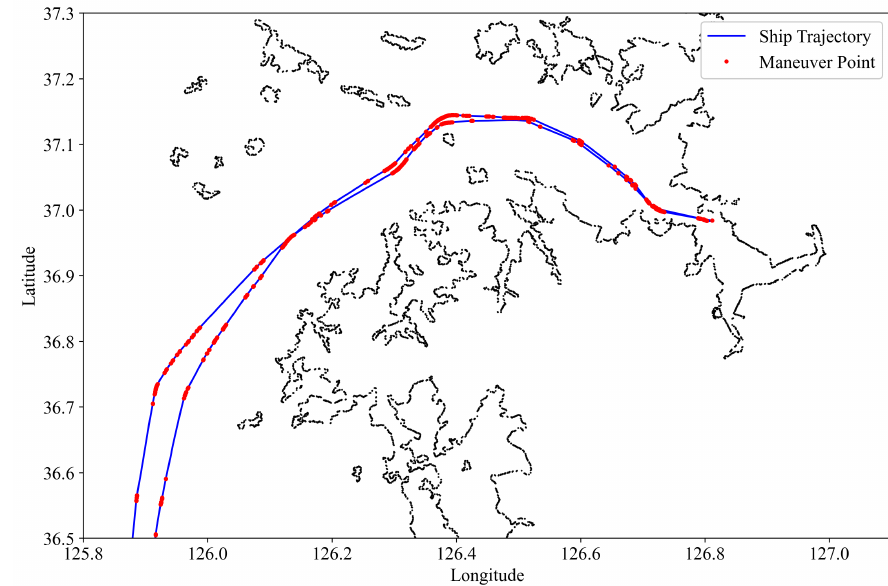
Figure 3. Maneuvers detected from course variance analysis.